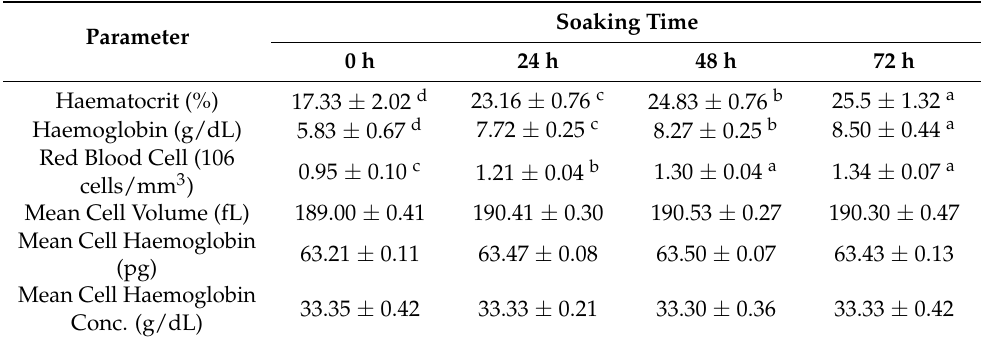
Table 5. Haematological parameters of African catfish Clarias gariepinus fed soaked Jatropha curcas kernel-based diets. Numbers are means ± standard